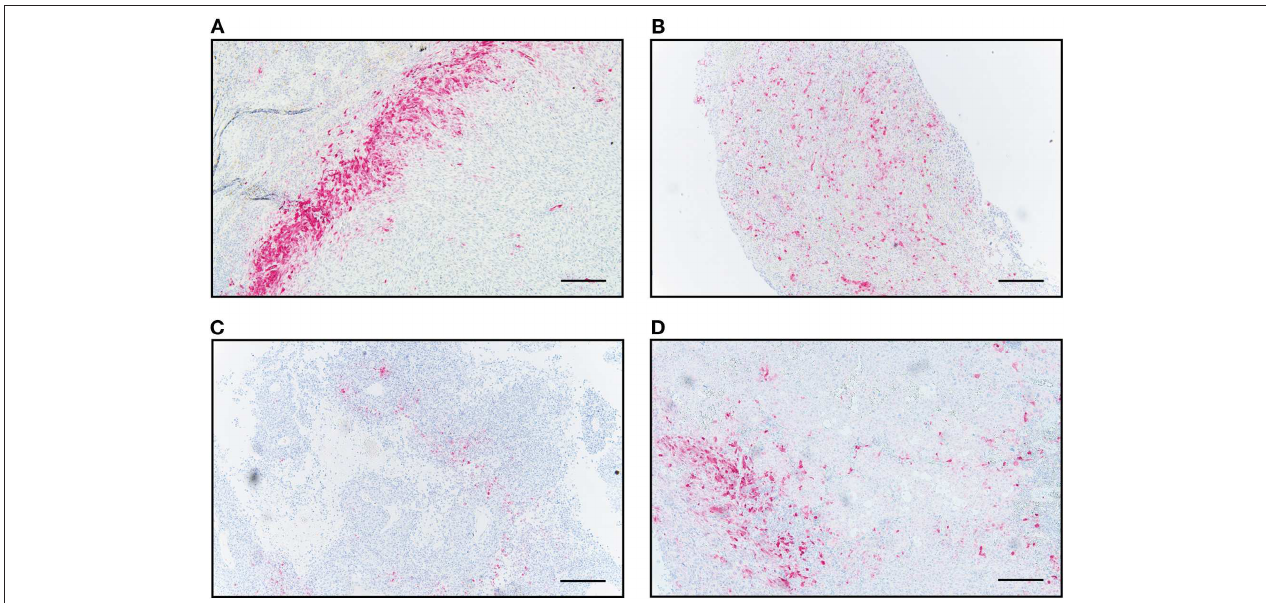
FIGURE 1 | Immunohistochemical and pathological analyses of IDO distribution in human melanoma metastases. Four distinct infiltration patterns of IDO-positive cells were predominantly detected independent of intracranial or extracranial origin. Representative images for the individual distribution patterns are presented in intracranial metastases. IDO-positive cells in a (A) “border-like,” (B) “diffuse,” (C) “partial rim” and (D) combined “partial rim plus diffuse” localization. Scale bar, 200 µ